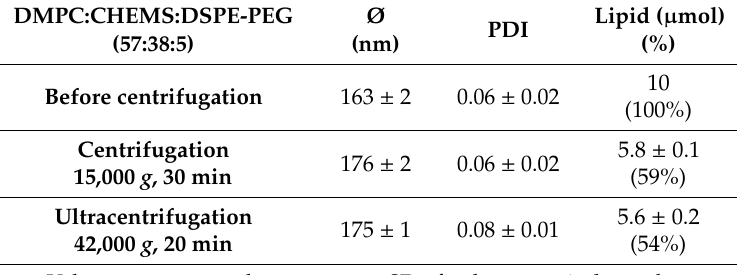
Table 1. Size and lipid content of liposomes co-loading IONPs and Cuphen before and after short centrifugation cycles.